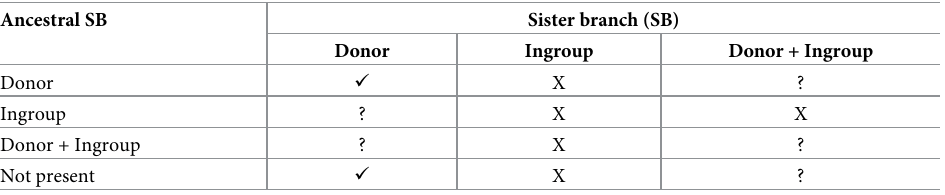
Table 1. Detection table whether the gene tested is an HGT